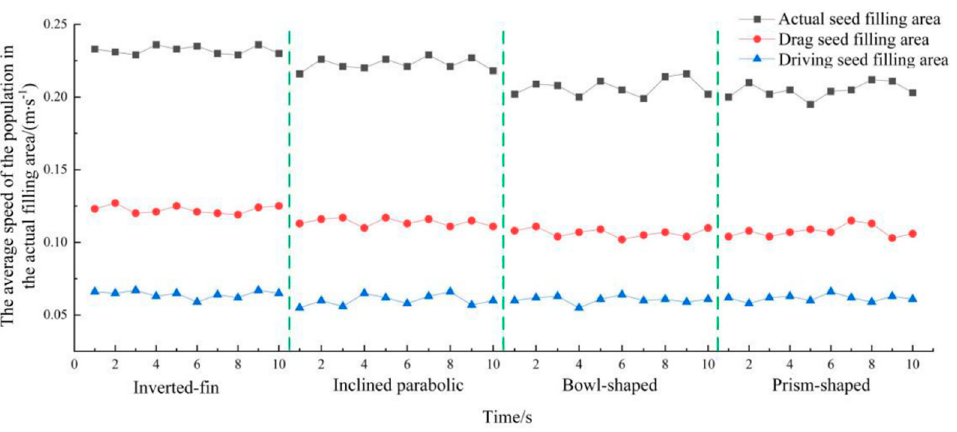
Figure 13. The average speed of the population in the three areas.